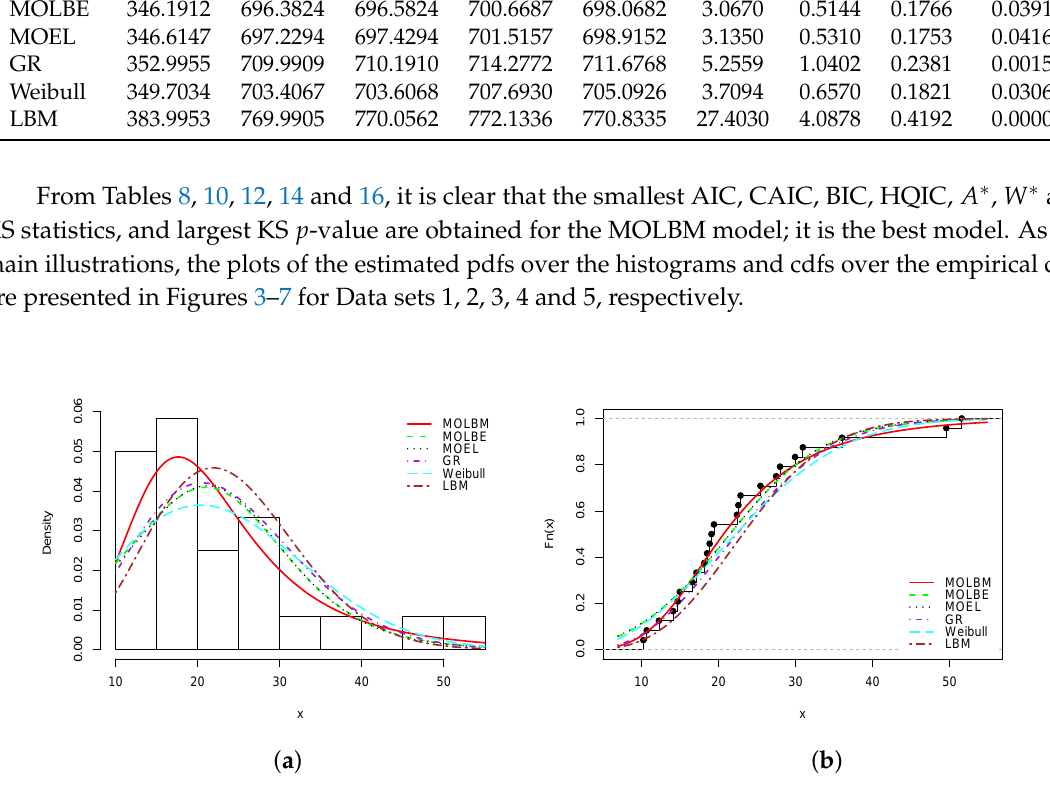
Figure 3. Plots of ( a ) estimated probability density function (pdf) and ( b ) estimated cumulative distribution function (cdf) of the MOLBM model with those of the other competitive models for Data set